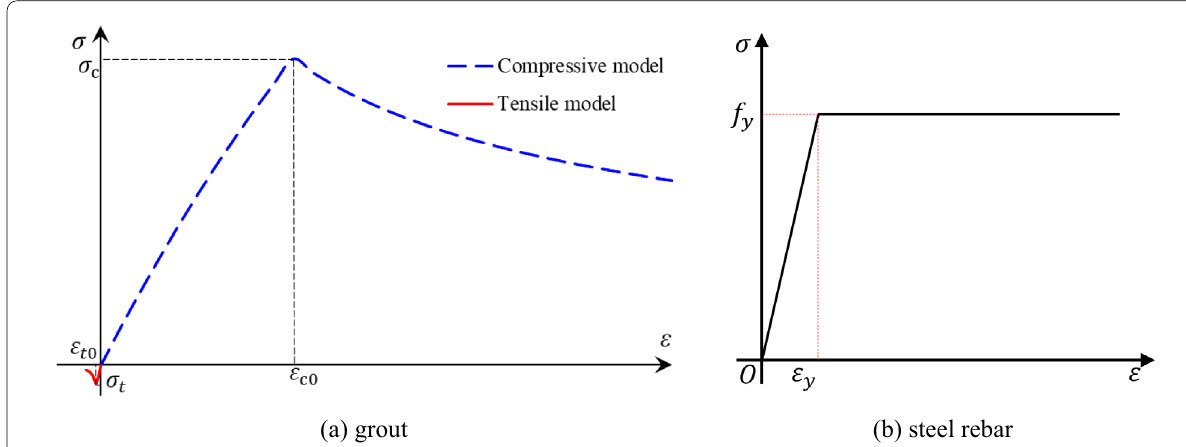
Fig. 9 Constitutive models of materials.